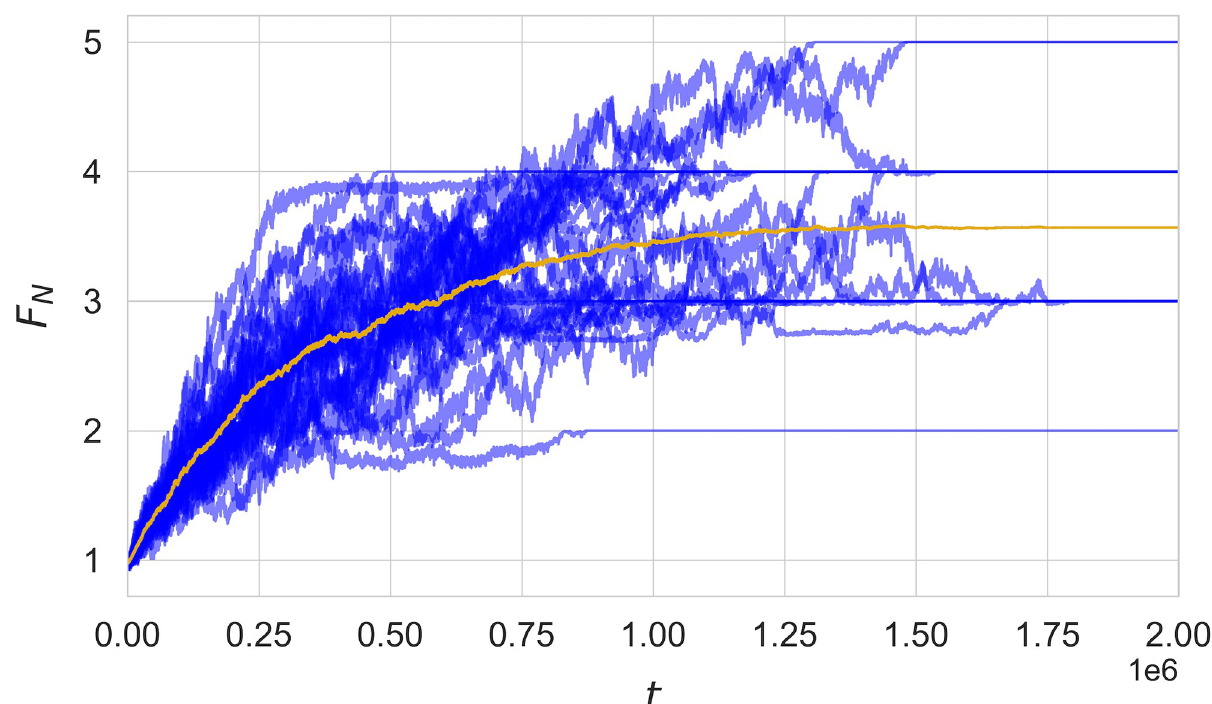
Fig 2. Example of evolutionary dynamics for various realizations of the Monte Carlo simulation and an averaged over 30 runs. The average payoff F N is shown for both individual runs (blue lines) and their average (orange line). This example is for N = 400 run on a scale-free network, with F max = 5 = 2 × 10 6 and t max